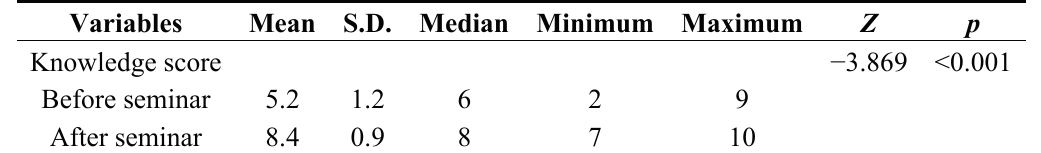
Table 3. Comparison of the total score of vaccination knowledge of surveyed caregivers before and after the health education seminar.